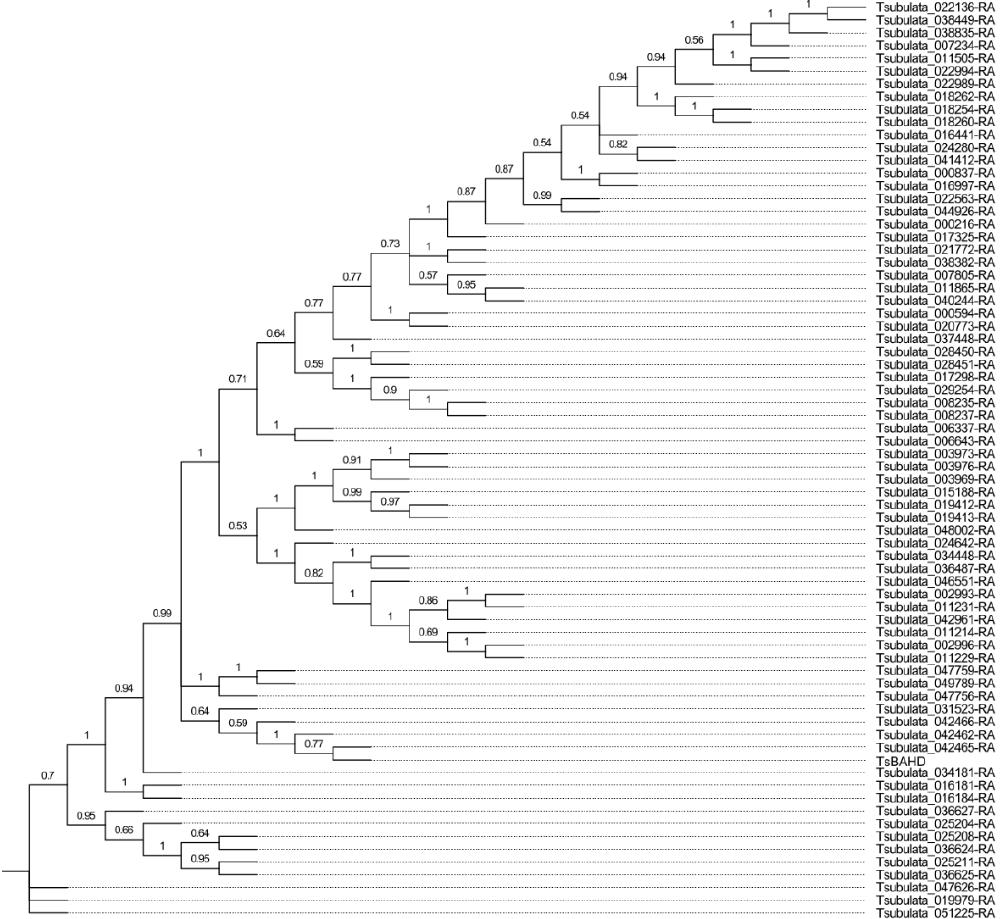
Figure 4. Phylogenetic relationship of the BAHD gene family in Turnera subulata . Generated using MEGA11 [30]. Values at nodes represent proportions from 1000 bootstrap replicates. Additional information related to motifs and intron/exon structure can be found in Supplementary Figure S6.